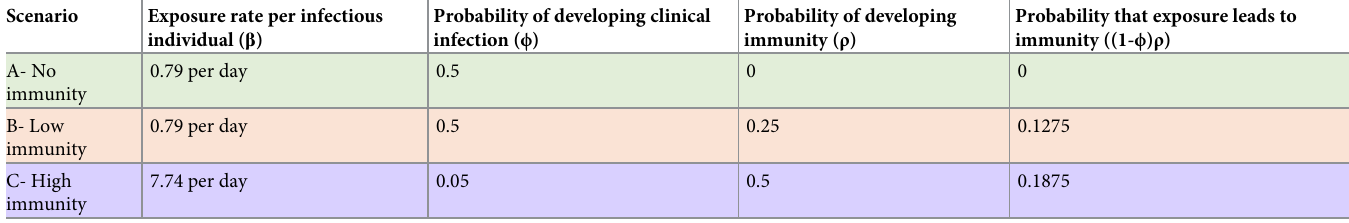
Table 2. Parameter values for naturally acquired immunity scenarios A, B and C.